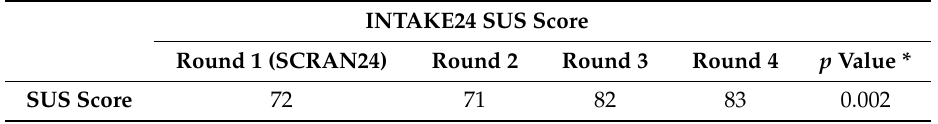
Table 3. SUS (System Usability Scale) score for INTAKE24 from all four stages of testing. * p < 0.05 = statistically